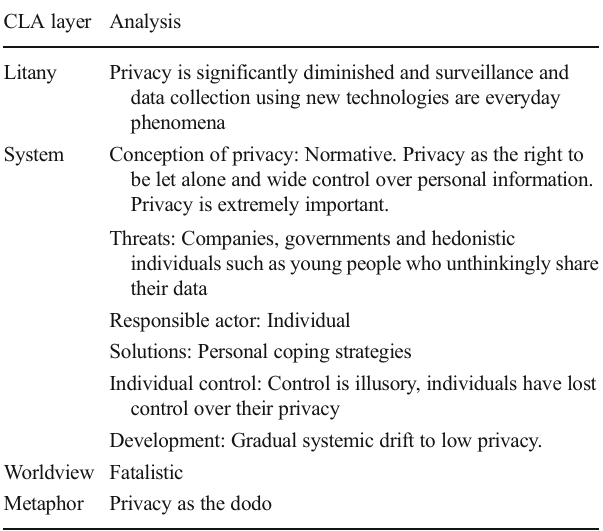
Table 3 Causal layered analysis of privacy as the dodo ( n = 12) CLA layer